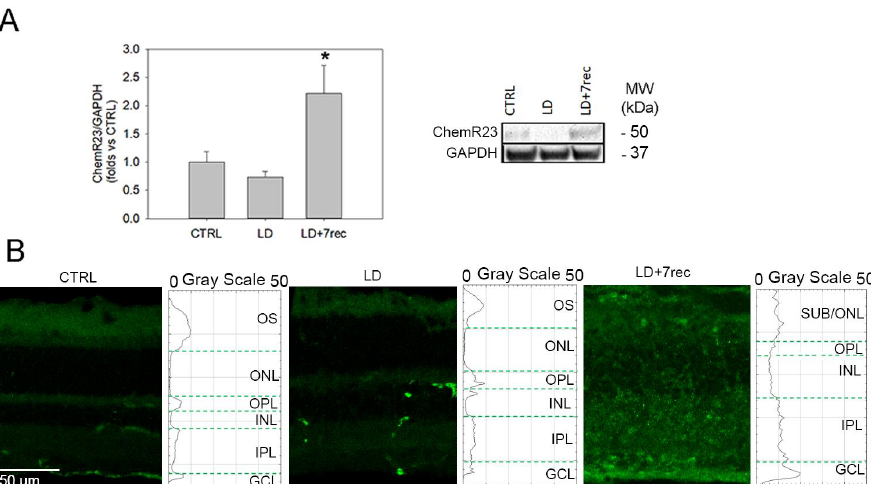
Figure 3 . ChemR23 analysis. ( A ) Western blot analysis of ChemR23 in eye cup samples of all the experimental conditions. Statistical analysis was one-way ANOVA test followed by Tukey test. Data are shown as mean ± SE ( n = 6). * p < 0.05 versus CTRL. The whole Western blot is available as Supplementary Figure S4. ( B ) Confocal images of retinal cryosections immunolabelled for ChemR23 (green) acquired at the central dorsal area of the retina. Scale bar: 50 µm. The graphs show the plot profile fluorescence intensity of ChemR23 throughout the retinal layers. CTRL (Control); LD (Light damage); LD + 7rec (Light damage + 7 days of recovery); OS (outer segments); ONL (Outer nuclear layer); OPL (outer plexiform layer); INL (Inner nuclear layer); IPL (inner plexiform layer); GCL (Ganglion cell layer).